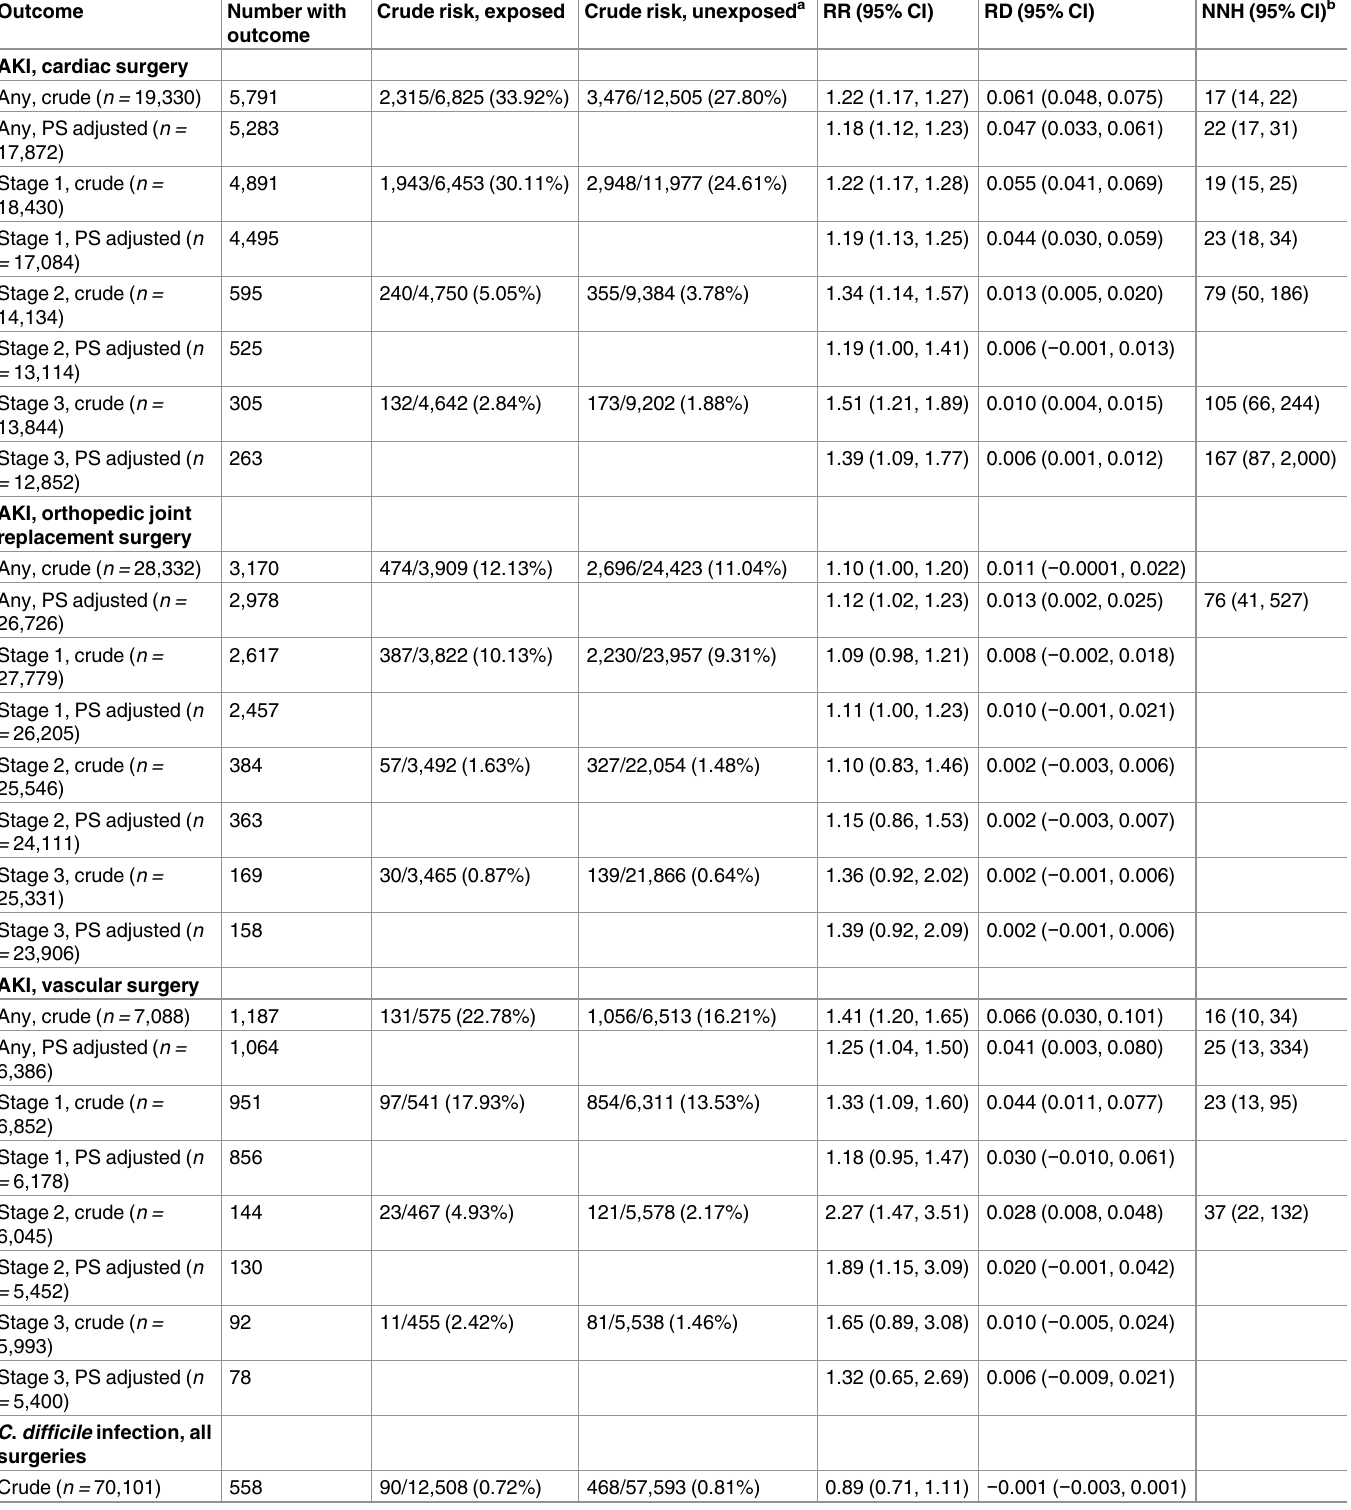
Table 3. Results of propensity-score-based analysesof the effect of antibiotic regimen on secondary outcome incidence.